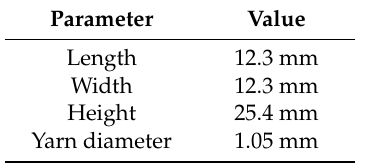
Table 2. Parameters of printed braiding structure.